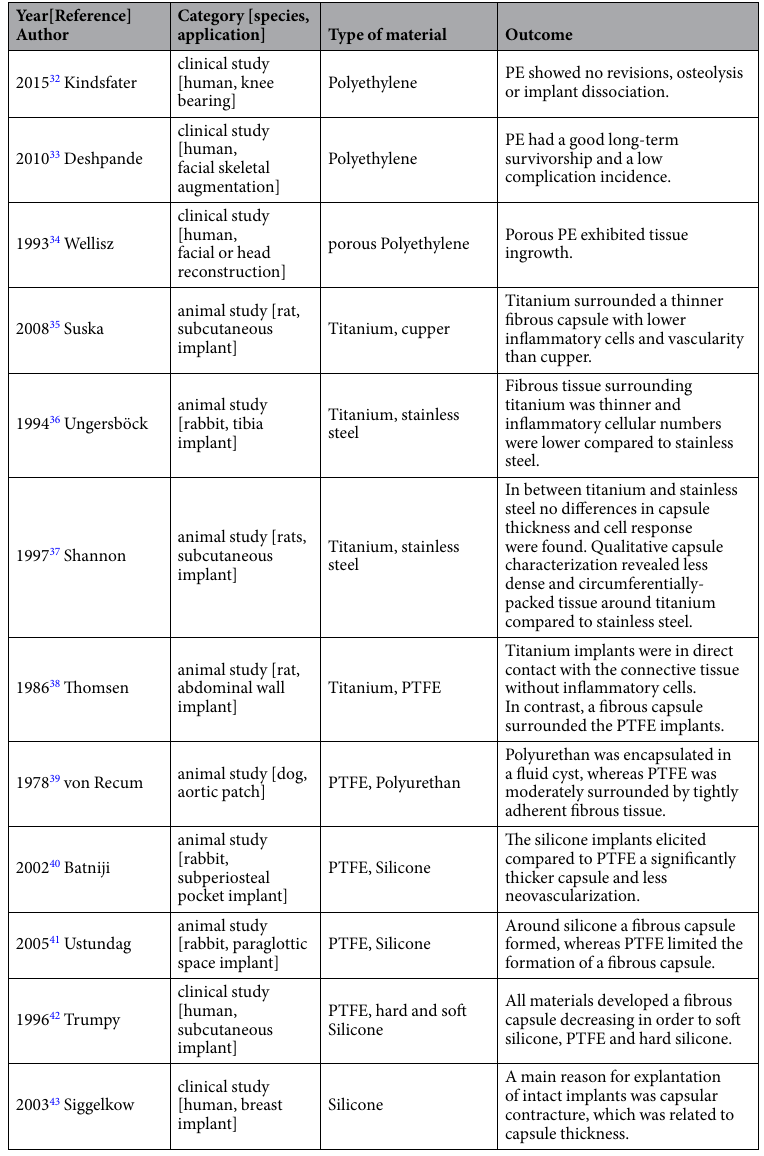
Table 1. Preclinical and clinical studies allowed a comparison and evaluation of the test materials regarding their fibrotic tendencies. These studies emphasized an increasing fibrotic response from PE, titanium, PTFE to silicone. This literature-based biomaterial ranking finally substantiated the validation of our test conditions on their predictive